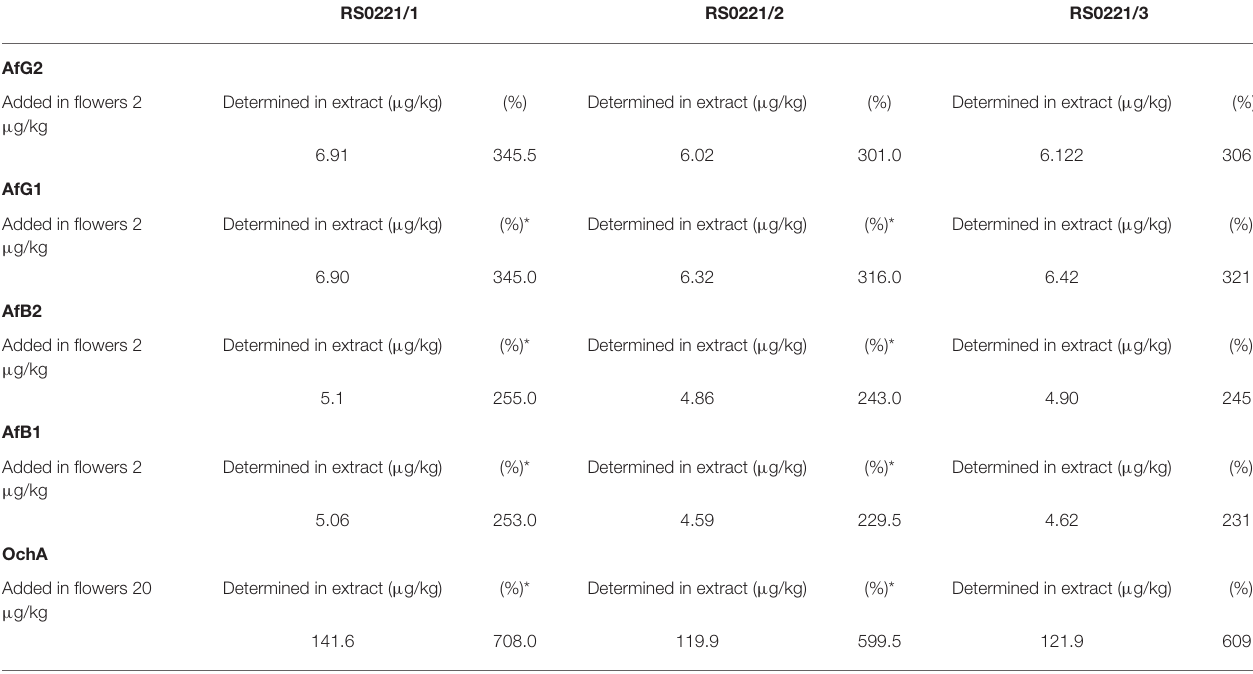
TABLE 7 | The content of Aflatoxin B1, B2, G1, G2 and Ochratoxin A in cannabis extract obtained from cannabis flowers spiked with maximum allowed residual level for aflatoxins and ochratoxin